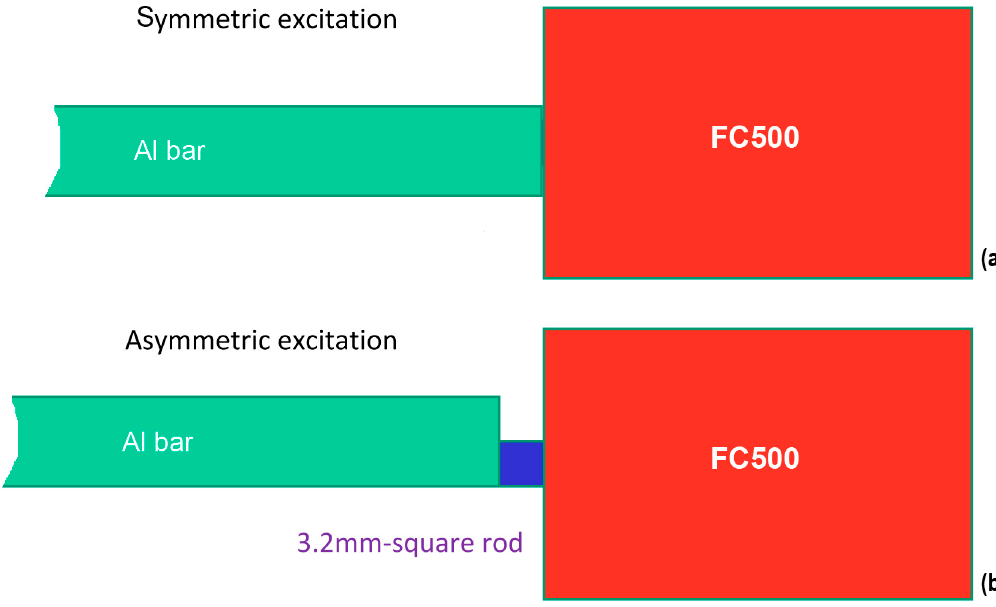
Figure A1. Bar wave generation utilizing symmetric excitation method ( a ) and asymmetric excitation method ( b ).